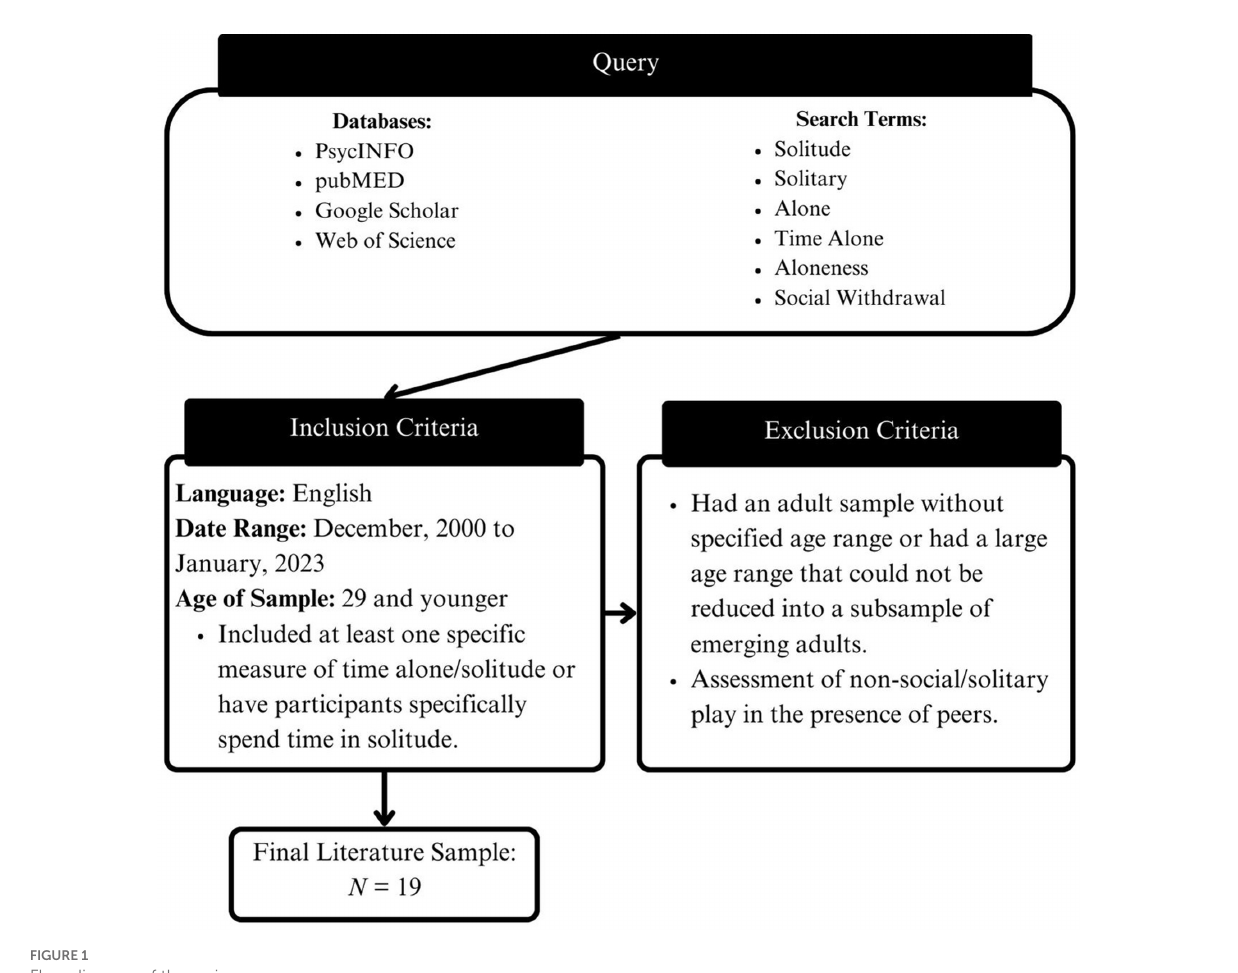
FIGURE 1 Flow diagram of the review